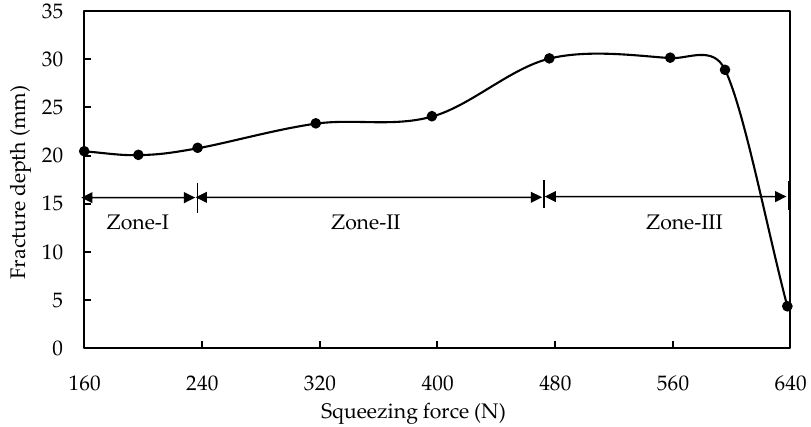
Figure 6. Variation for forming depth under different supporting forces (reprinted with permission from B. Lu et al. [38], Copyright 2015 Elsevier).